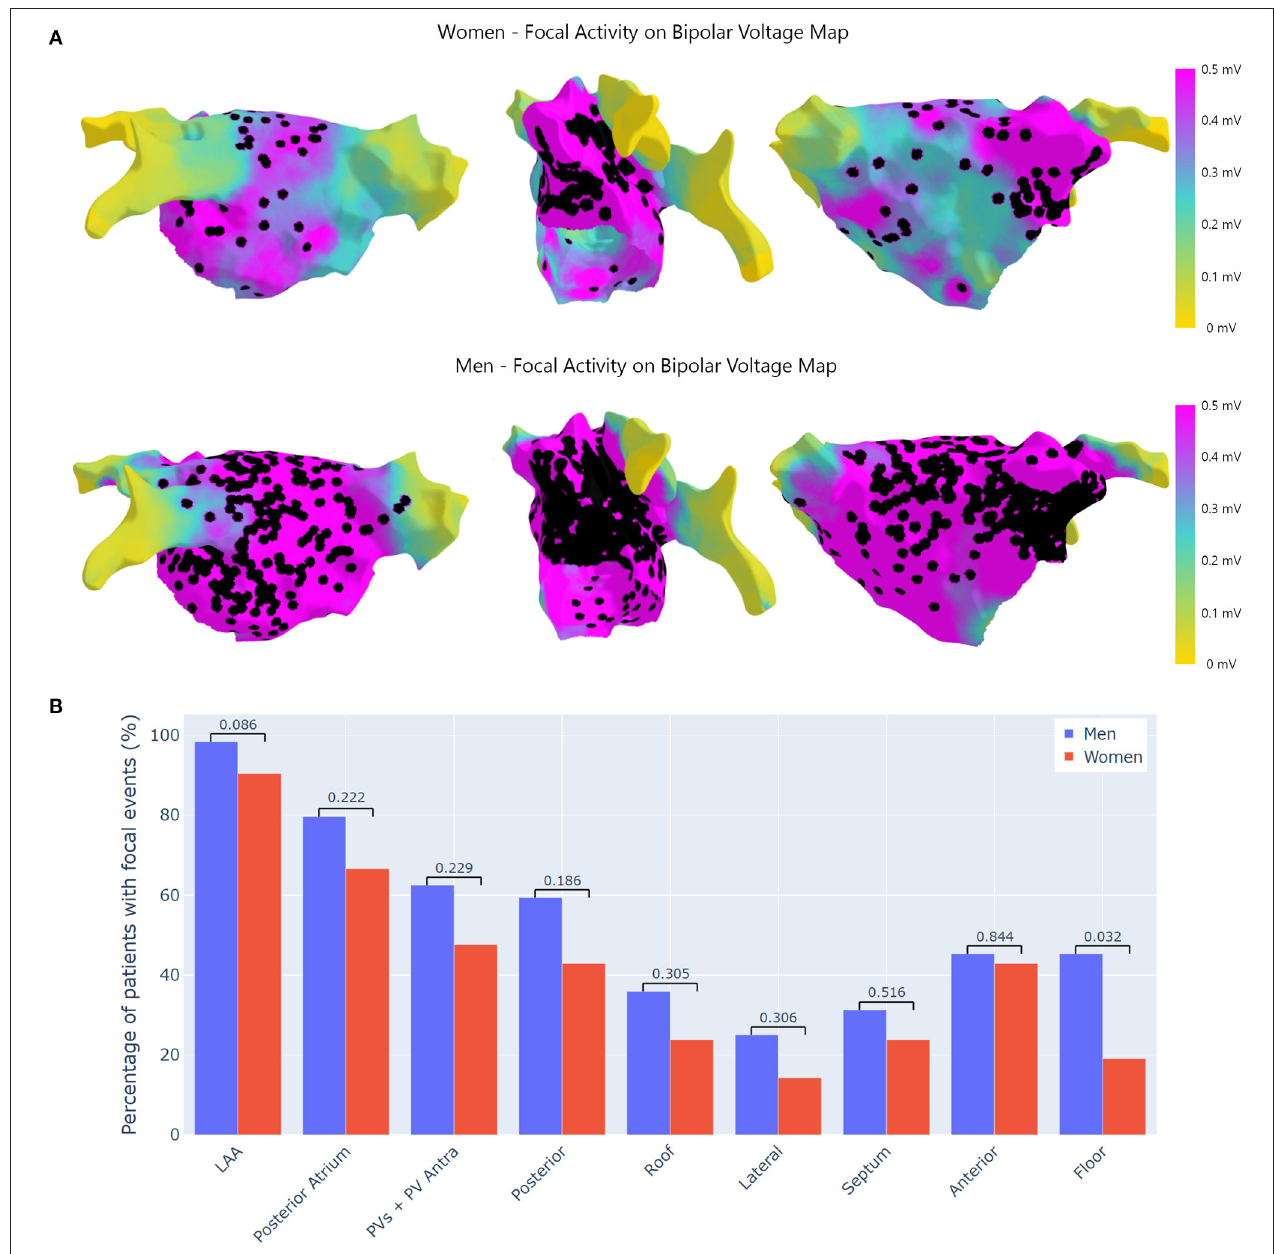
FIGURE 4 | Location of focal activity. (A) Top: focal activity in women. Bottom: focal activity in men. Focal activity located in all the LA, with high density predominance in the LAA where it is more frequently detected for all the patients. (B) Differences in focal activity by regions. This figure shows the percentage (%) of patients with focal activity at the pre-specified regions of the LA. LAA, left atrial appendage; PVs, pulmonary veins.